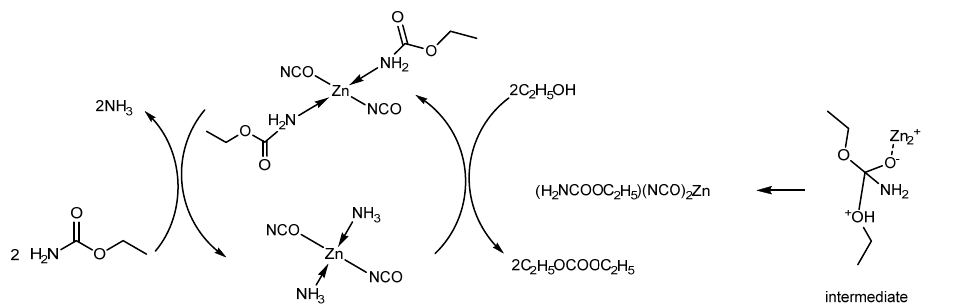
Figure 8. The reaction mechanism of diethyl carbonate (DEC) production, as proposed by Wang et al. [72]. (Reprinted with permission from Ref. [72], 2010, Springer Nature).